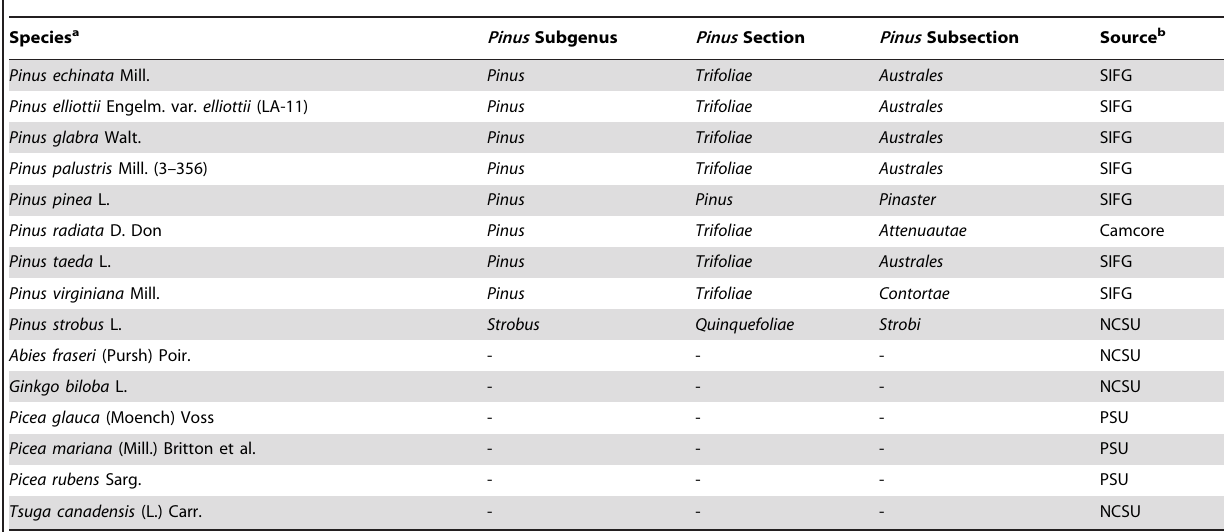
Table 4. Gymnosperms used in Southern blot